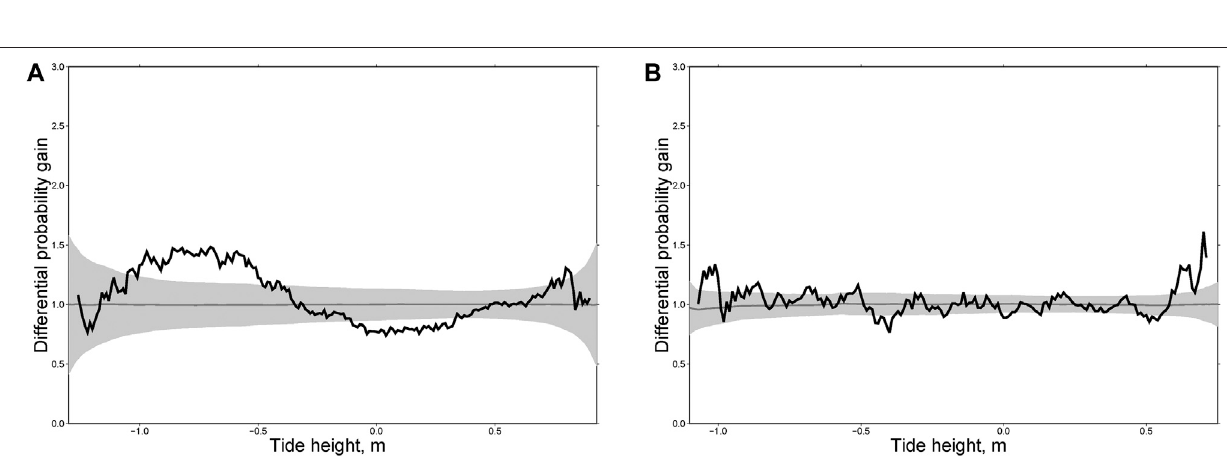
Frontiers in Earth Science |